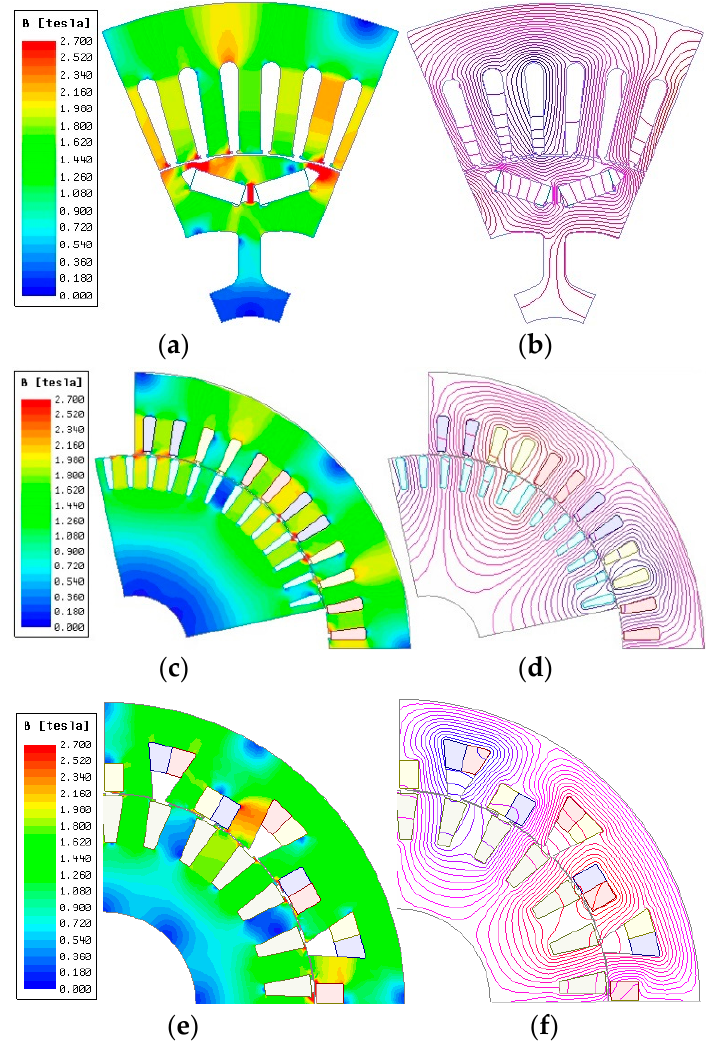
Figure 4. Flux density and flux line distributions of the machines. ( a ) IPM machine flux density. ( b ) IPM machine flux line. ( c ) CIM flux density. ( d ) CIM flux line. ( e ) AIM flux density. ( f ) AIM flux line.